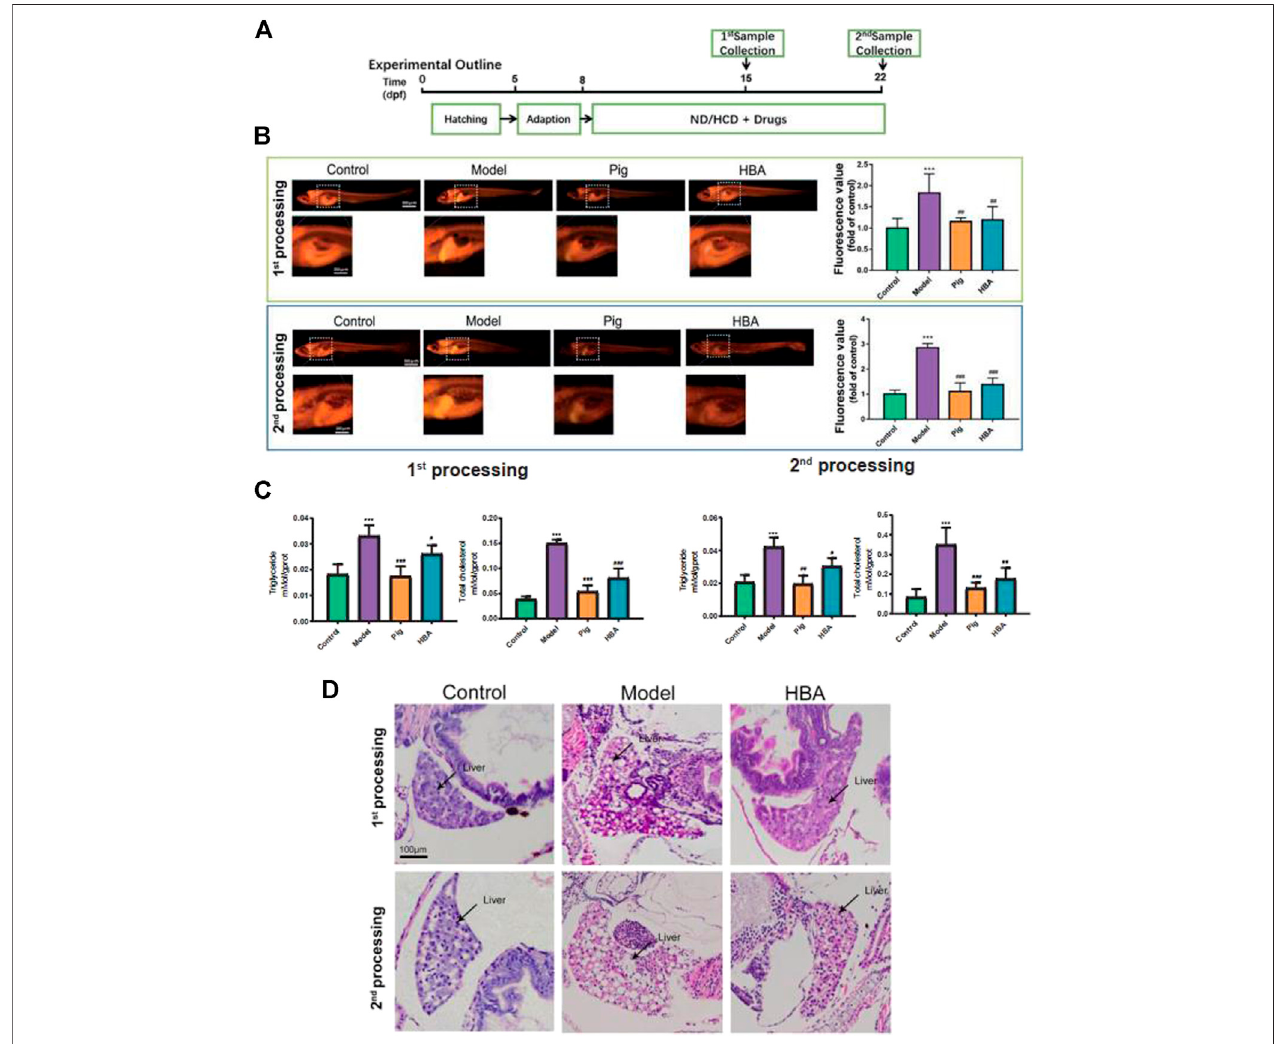
FIGURE2| EffectofHBAinregulatinglipidmetabolismonanHCD-InducedLarvalZebra fi shModelintwoprocesses. (A) Experimentaloutlineofthelarvalzebra fi sh experiment in vivo . (B) Nile red stain of larval zebra fi sh and fl uorescent quantitation. (C) Triglyceride (TG,mmol/gprot) and total cholesterol (TC,mmol/gprot) of larval zebra fi sh. (D) Hematoxylin and eosin (HE) staining of larval zebra fi sh liver, macrovesicular steatosis, and the differences mentioned with black arrows. Bar indicate means ± SD. ***p < 0.001representcomparedwiththecontrol;# p < 0.05, ##p < 0.01, ###p < 0.001representcomparedwithModel. p < 0.05wasconsideredas statistically signi fi cant calculated by One-way ANOVA followed by Tukey ’ s test ( n (cid:1) 3, n indicates the replicates of experiment).